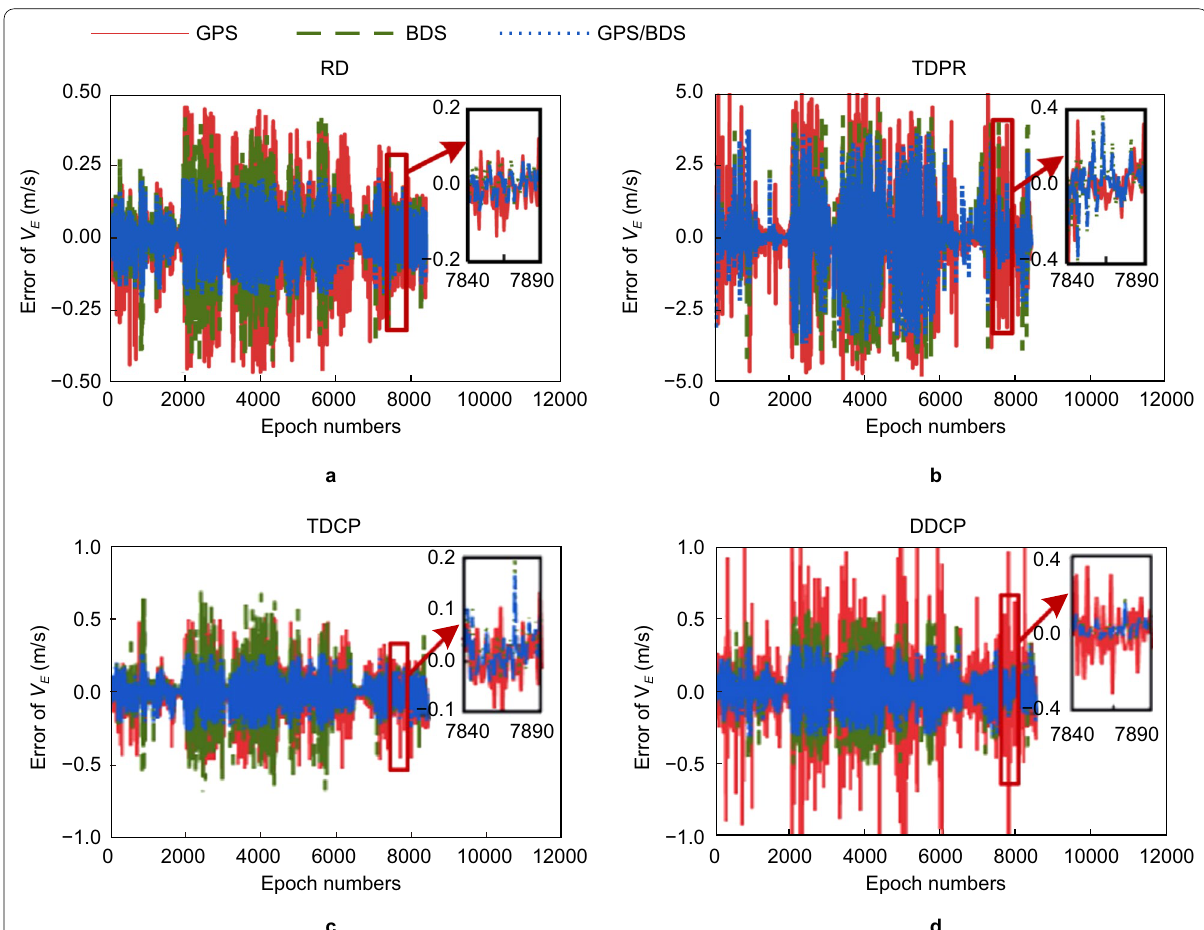
Fig. 10 Velocity determination accuracy and zoomed-in windows in east component for the RD- ( a ), TDPR- ( b ), TDCP- ( c ) and DDCP- ( d ) based methods in test